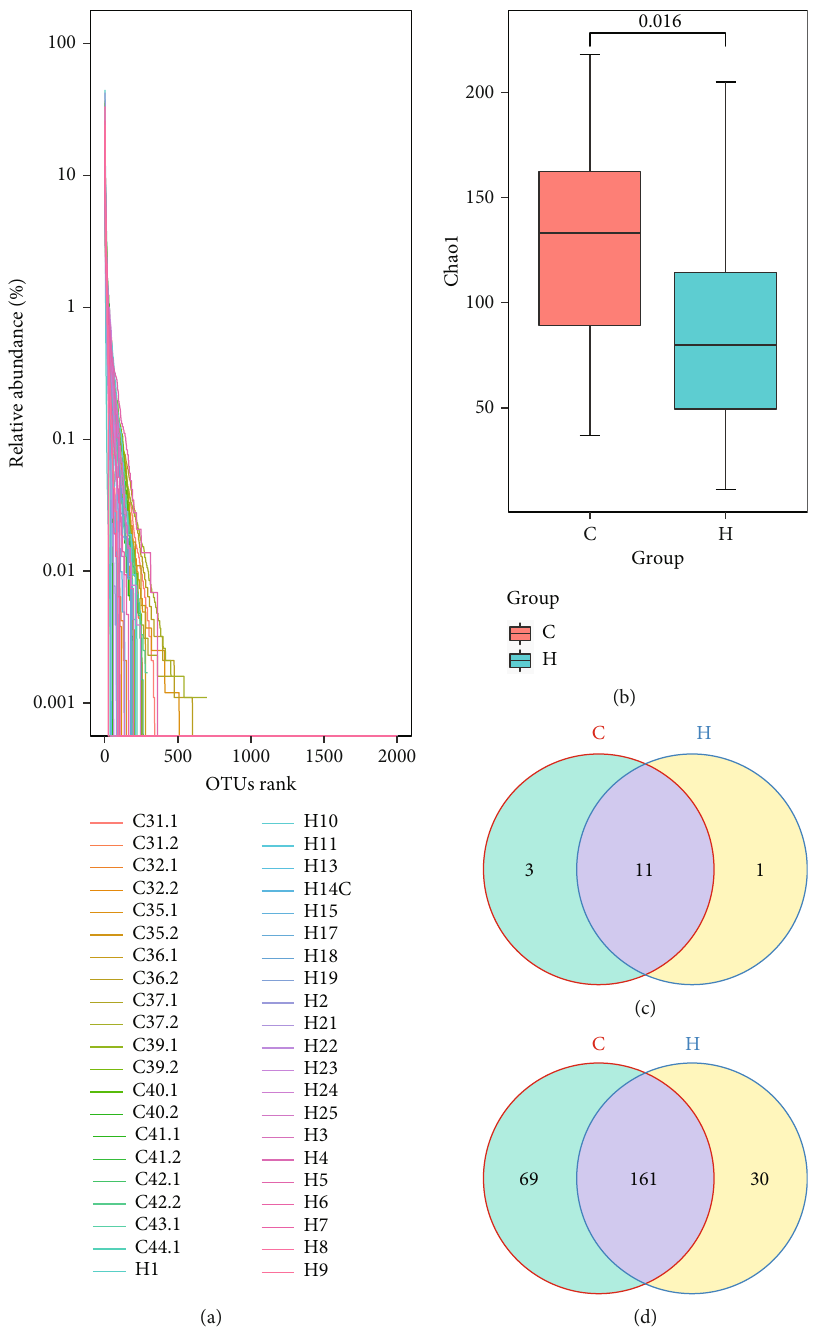
Figure 2: Changes of fecal microbiome. (a) The rank abundance curve. (b) The changes of Chao 1 index. (c) Venn diagram showed microbiota at the phylum level. (d) Venn diagram showed microbiota at genus level. C: healthy group; H: CHF